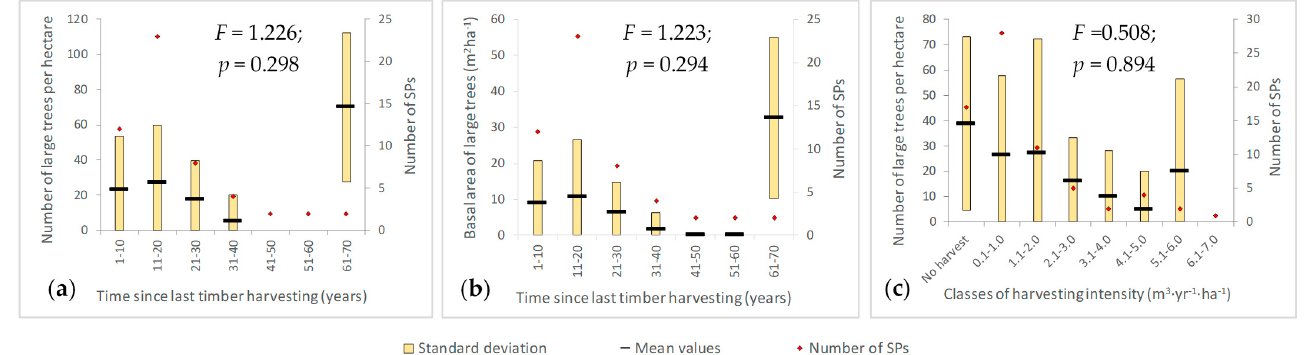
Figure 8. The number ( a ) and basal area ( b ) of large trees with respect to time since last harvest and harvesting intensity ( c ).